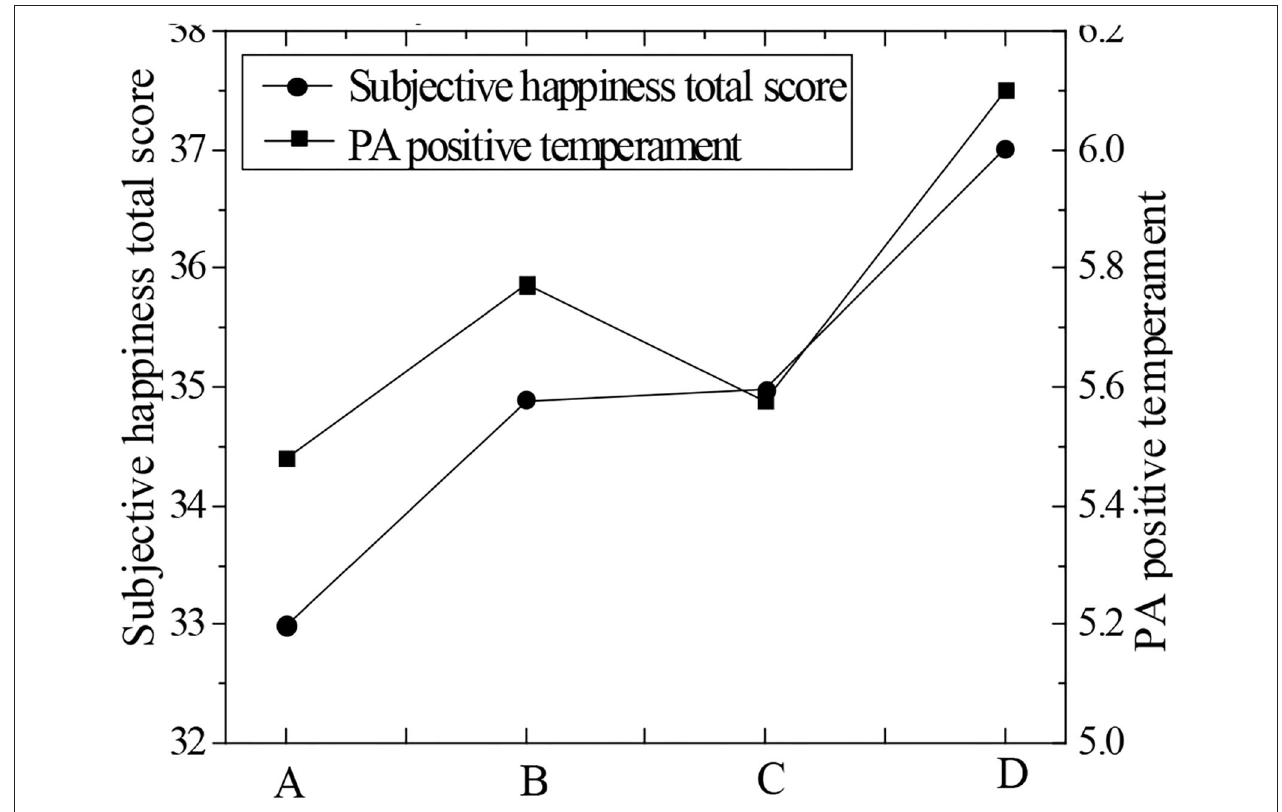
FIGURE 3 | Plot of mean value of total happiness score and PA positive emotion score of the four groups.